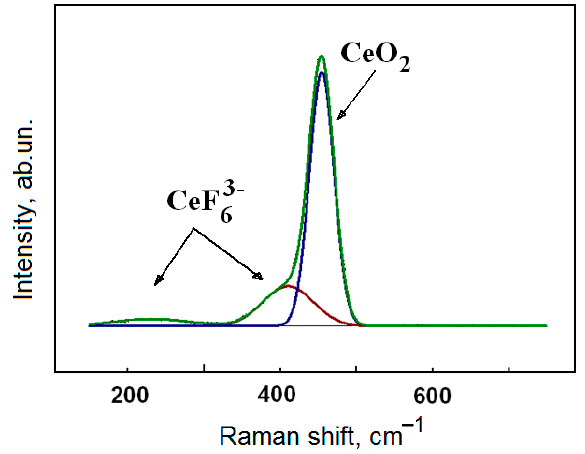
Figure 3. Analysis of the contour of the vibrational band in the Raman spectrum of the 0.85FLiNaK–0.15CeF 3 composition recorded at 600 °C and 4 min exposure in the air atmosphere.